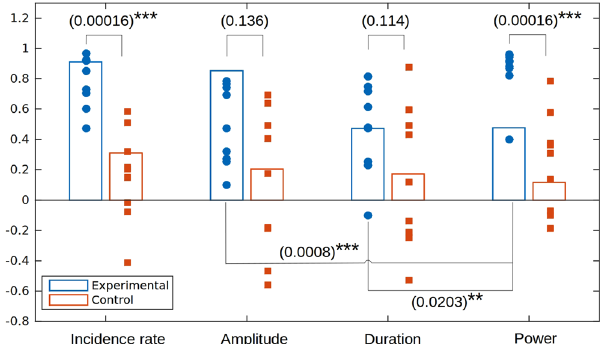
Figure 8. Summary of the results of the correlation analysis for different alpha-activity parameters for the experimental and control groups. For each subject, we plotted the points representing daily correlation coefficient for each of the four parameters of alpha activity: average power, spindles incidence rate, spindles amplitude and duration. Additionally, the bar plots represent average correlation coefficients for each group (blue for the experimental group; orange for the control group). Between group comparison shows that the experimental group data demonstrate high average correlation coefficients ( p < 0.0001) for the power and spindles incidence rate parameters. No significant correlations are observed for the control group. Only the average power and spindles incidence rate features demonstrate highly significant differences between the experimental and control groups (Wilcoxon rank-sum test, p = 0.00016). No statistically significant differences are observed between the experimental and the control groups for spindle amplitude ( p = 0.136) and spindle duration ( p = 0.114) features. Only within the experimental group we observe a highly significant positive difference between the studied correlation coefficients for the spindle incidence rate and spindle amplitude parameter ( p = 0.0008) as well as the spindle duration parameter ( p =